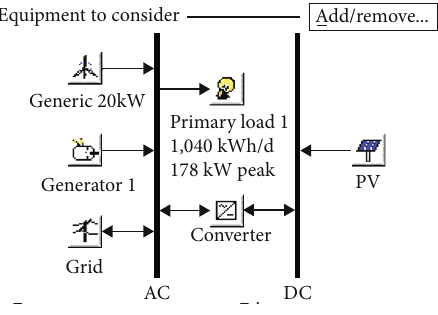
Figure 6: Schematic diagram of HOMER simulation